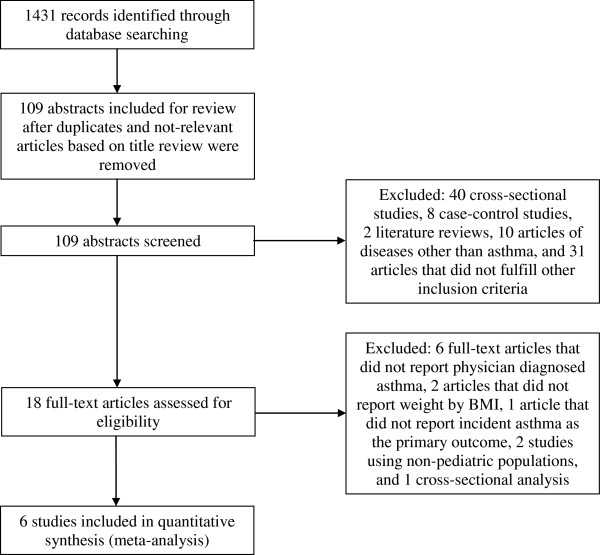
Study flow diagram: article search strategy results.